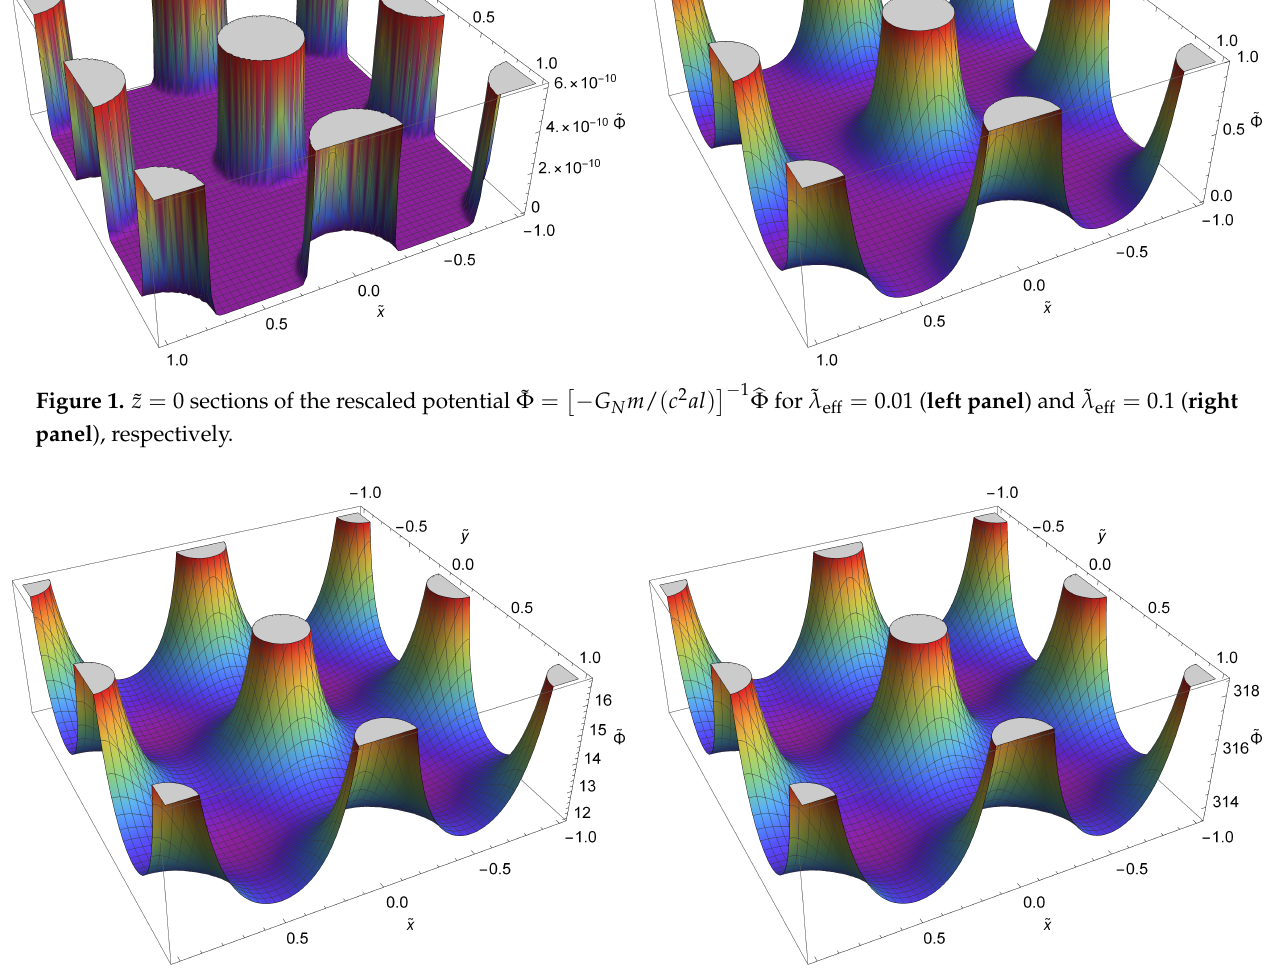
Figure 2. ˜ z = 0 sections of the rescaled potential ˜ Φ = panel ),